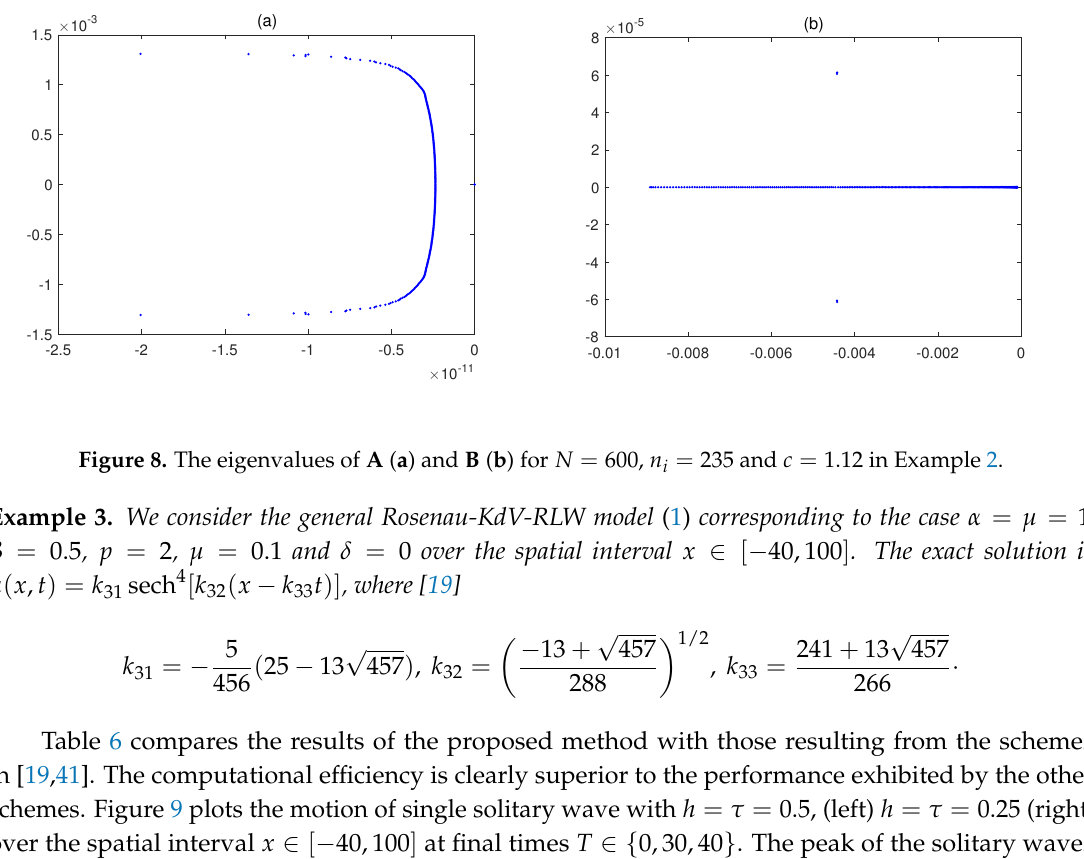
Figure 7. The absolute error L ∞ with τ = h = 0.05, at final times T = 30 ( a ) and T = 40 ( b ) over the interval x ∈ [ − 60,90 ] for Example 2.